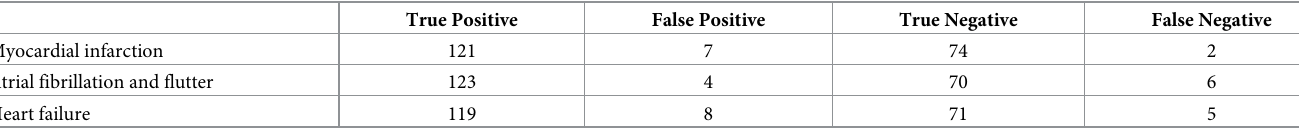
Table 4. Cross tabulation of the index test (ICD-9-CM code) for the results of the reference standard (medical chart).